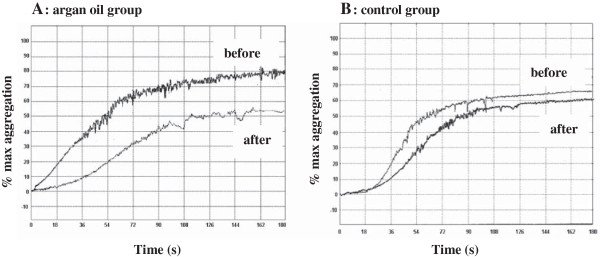
Original traces showing effect of argan oil on platelet aggregation. Isolated platelets were stimulated by exposure to 0.2 U/mL thrombin. before: before treatment; after: after treatment.